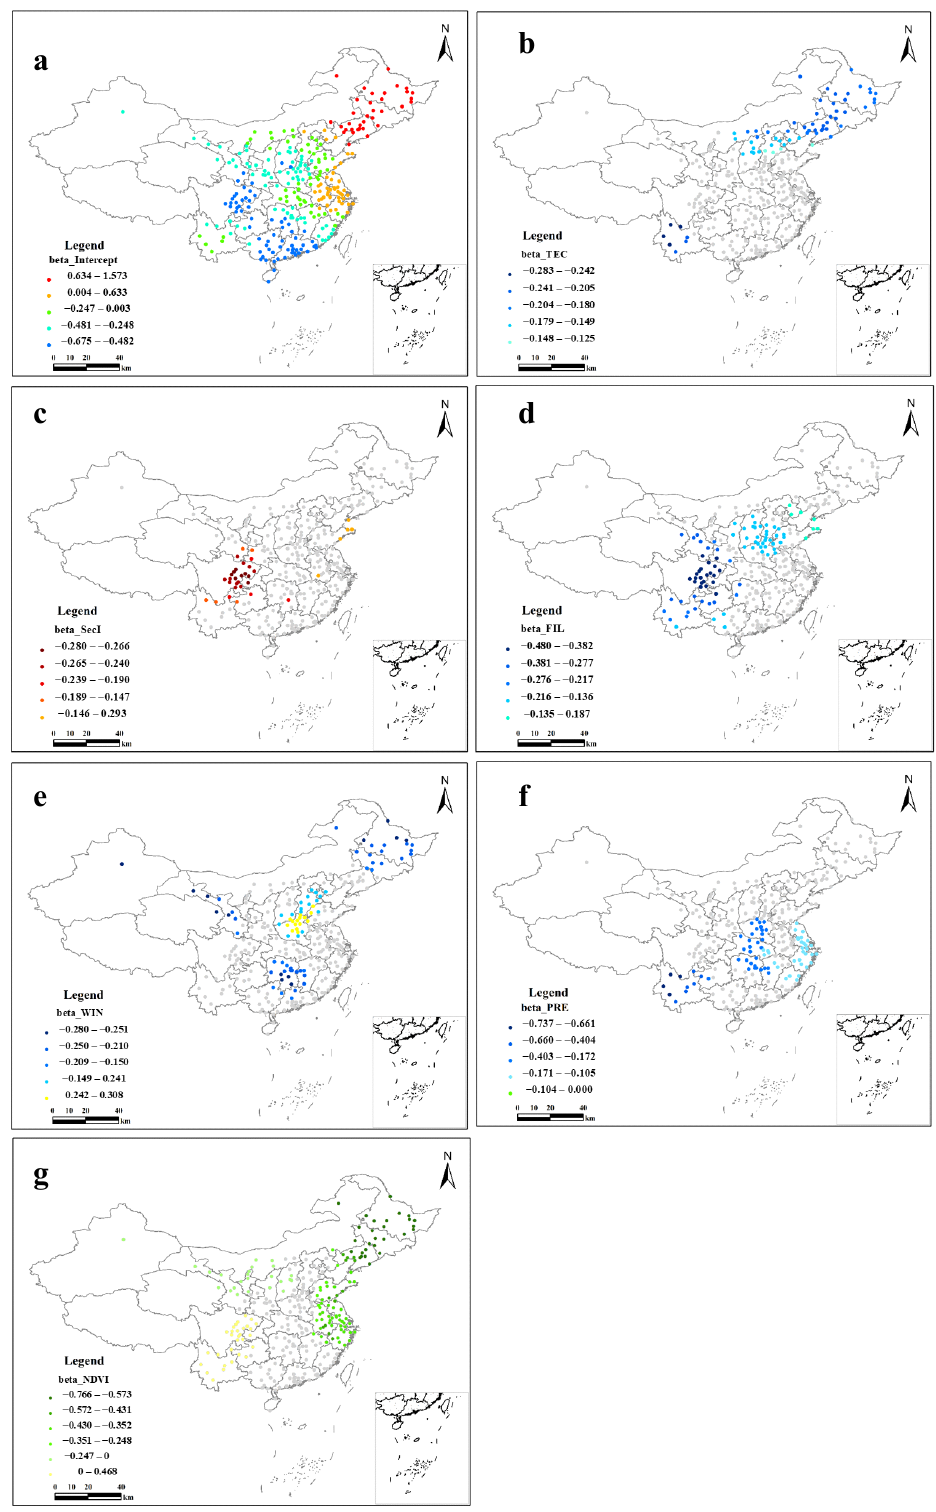
Figure 4. Spatial patterns of coefficients in the MGWR. The colored solid points denote cities that passed the 95% significance test ( p < 0.05), and the gray solid points denote cities that did not pass the 95% significance test ( p > 0.05). Interception ( a ); Technological progress ( b ); SecI ( c ); FIL ( d ); WIN ( e ); Precipitation ( f ); and NDVI ( g ). Note that only the coefficients of factors with significant spatial heterogeneity ( p < 0.05) are shown in the figure.